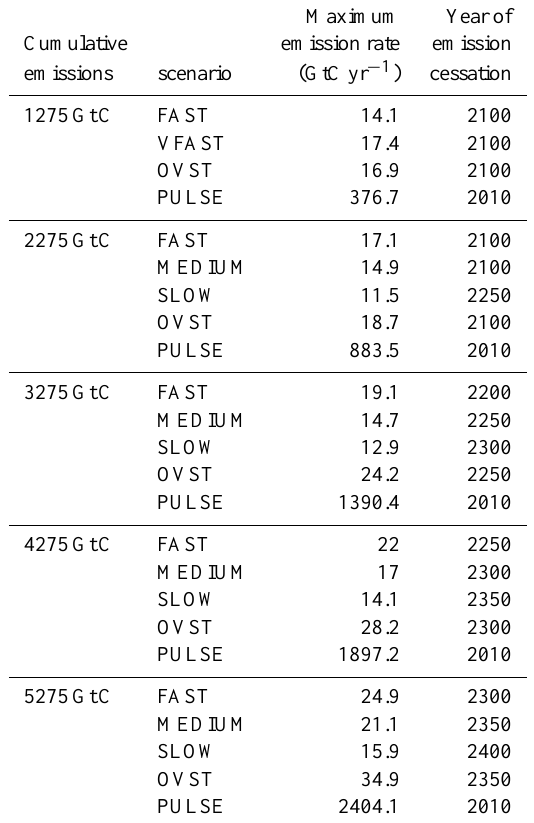
Table 1. The 24 emission scenarios and their characteristics. Emis- sions include both fossil fuel and land-use change emissions. Cu- mulative emissions are from year 1800